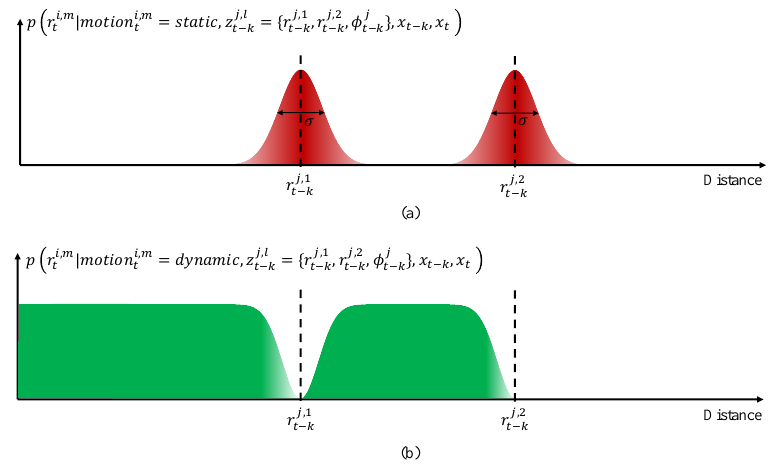
Figure 7. Likelihood of static ( a ) and dynamic ( b ) for one laser